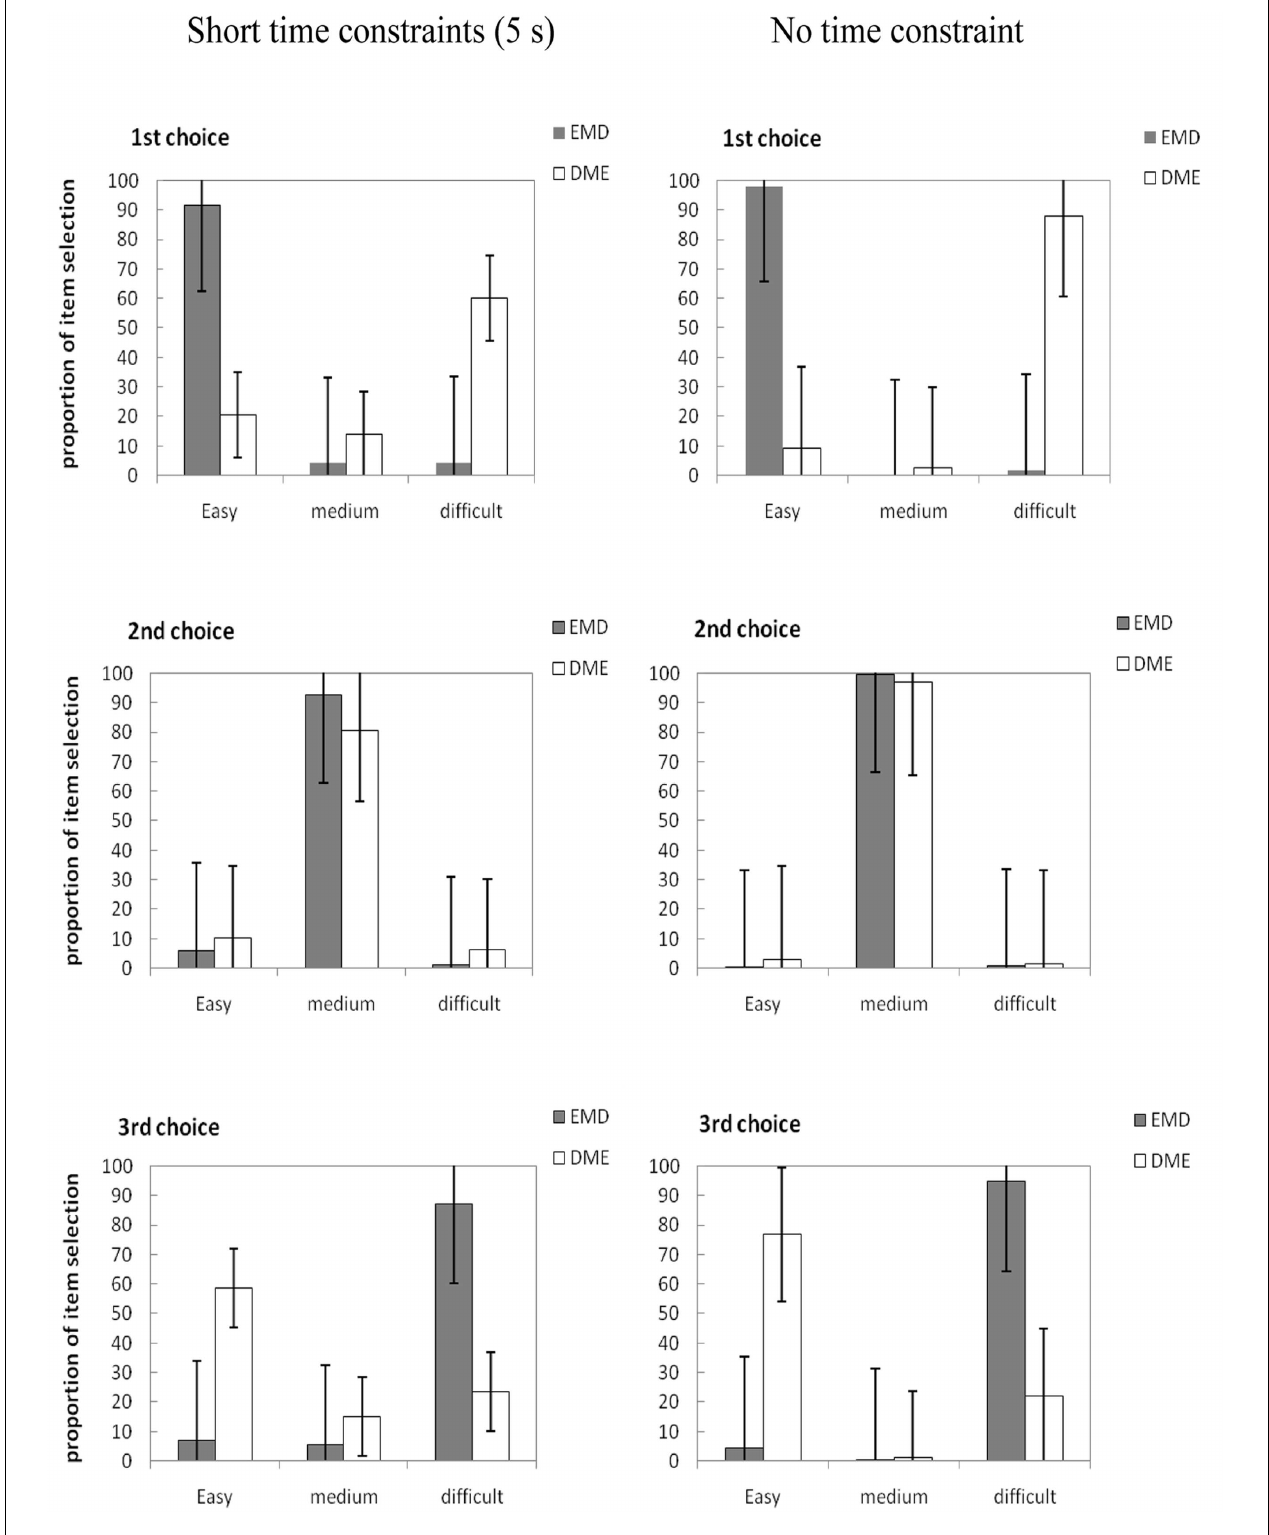
FIGURE 2 | Mean proportion of items selected for the first, second, and third choice across the word pair arrays in Experiment 2. E, easy word pair; M, moderately difficult word pair; D, difficult word pair. Error bars are standard errors of each mean.